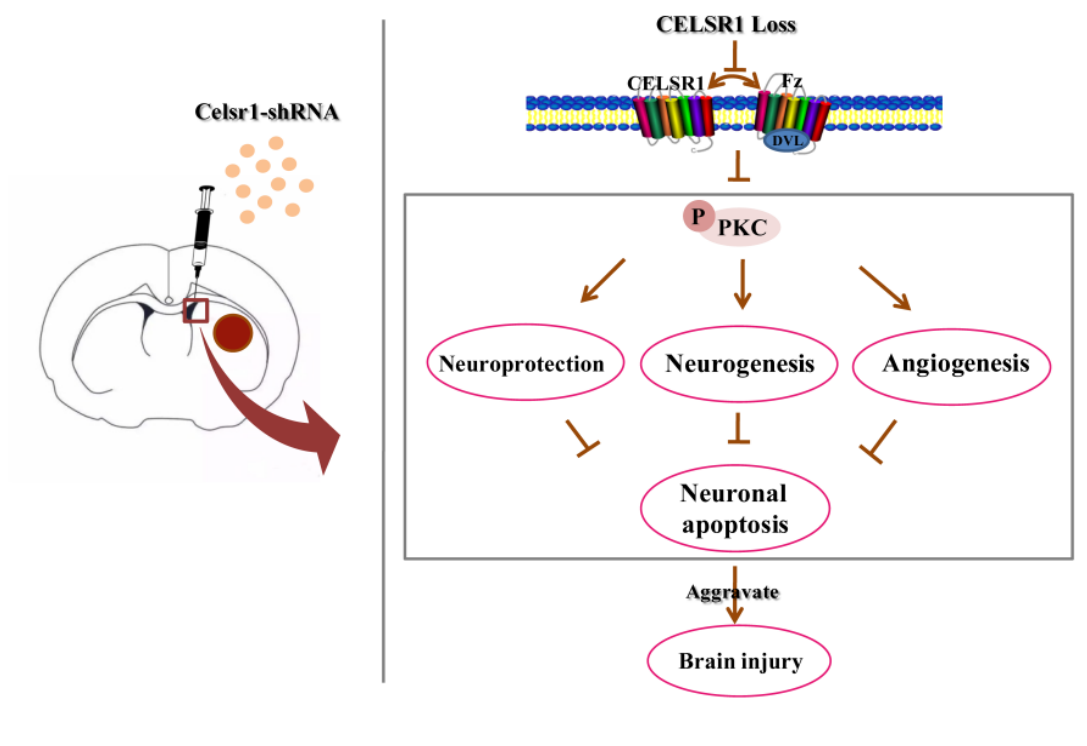
Figure 8. Schematic presentation of our findings showing the role of CELSR1 in the ischemic